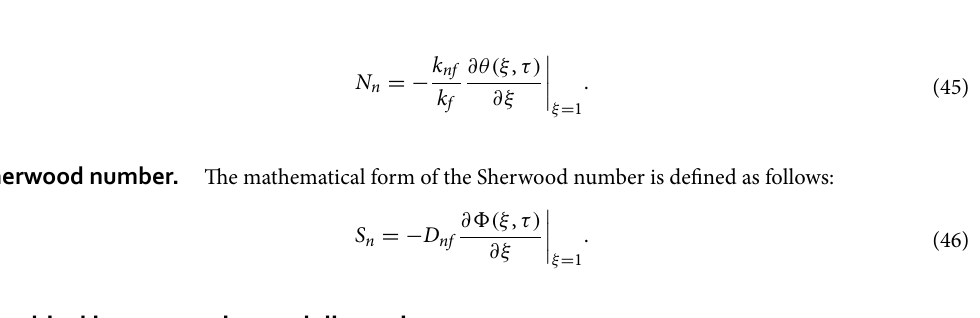
Figure 2. Fractional parameter α impact on the velocity profile, when, Gr π γ β 22.64 , and Sc 1 , Pr 4 , = = =